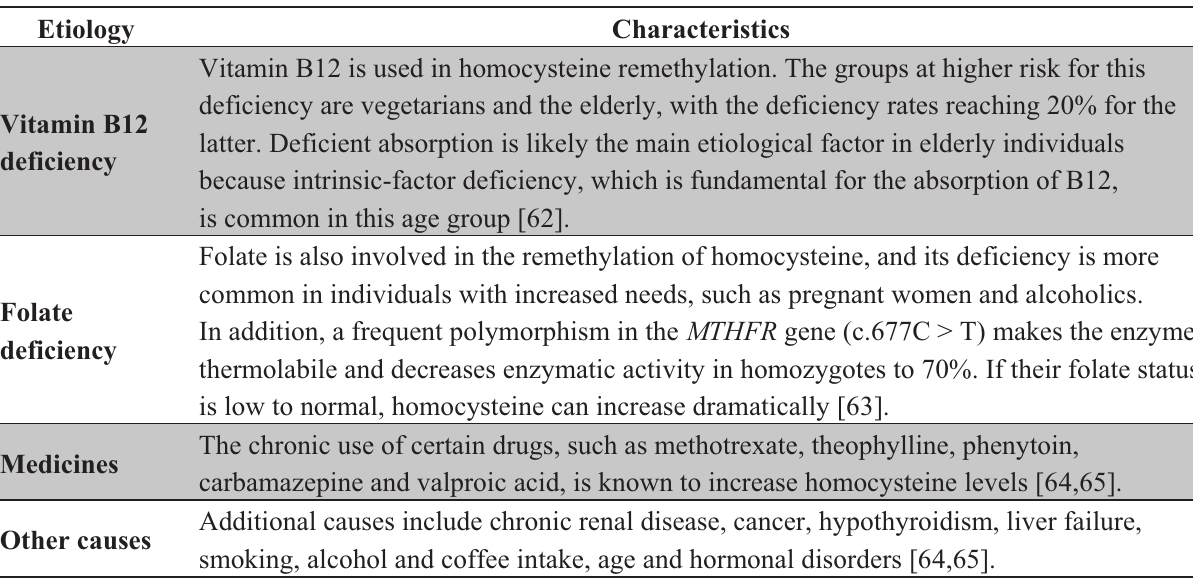
Table 1. Summary of the main causes of mild and moderate